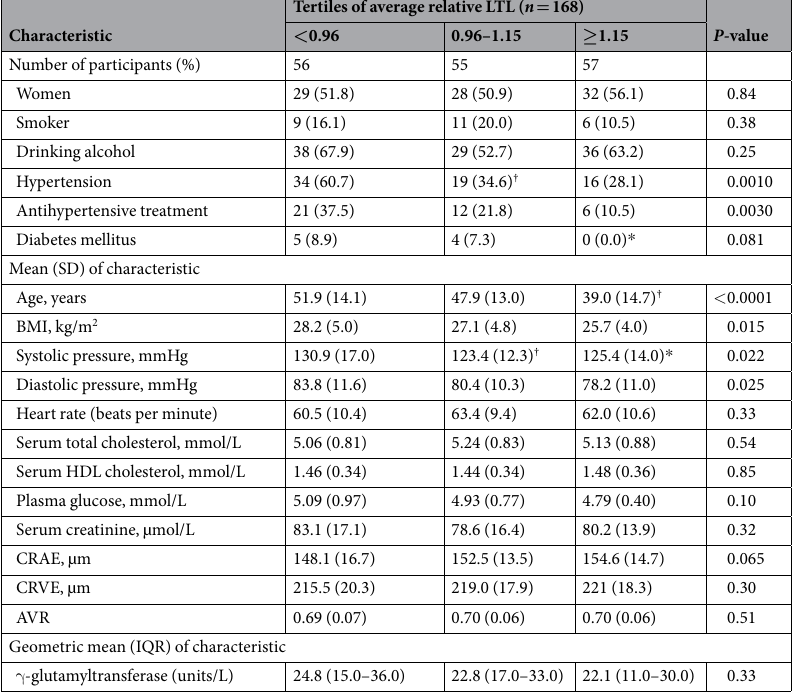
Table 1. Characteristics of participants at baseline by tertiles of leukocyte telomere length. Abbreviations: SD, standard deviation; LTL, leukocyte telomere length; BMI, body mass index; HDL, high-density lipoprotein; CRAE, central retinal arteriolar equivalent; CRVE, central retinal venular equivalent; AVR, arteriole-to-venule ratio; IQR, interquartile range. Significance of the differences with the left adjacent group: * P ≤ 0.05, † P ≤